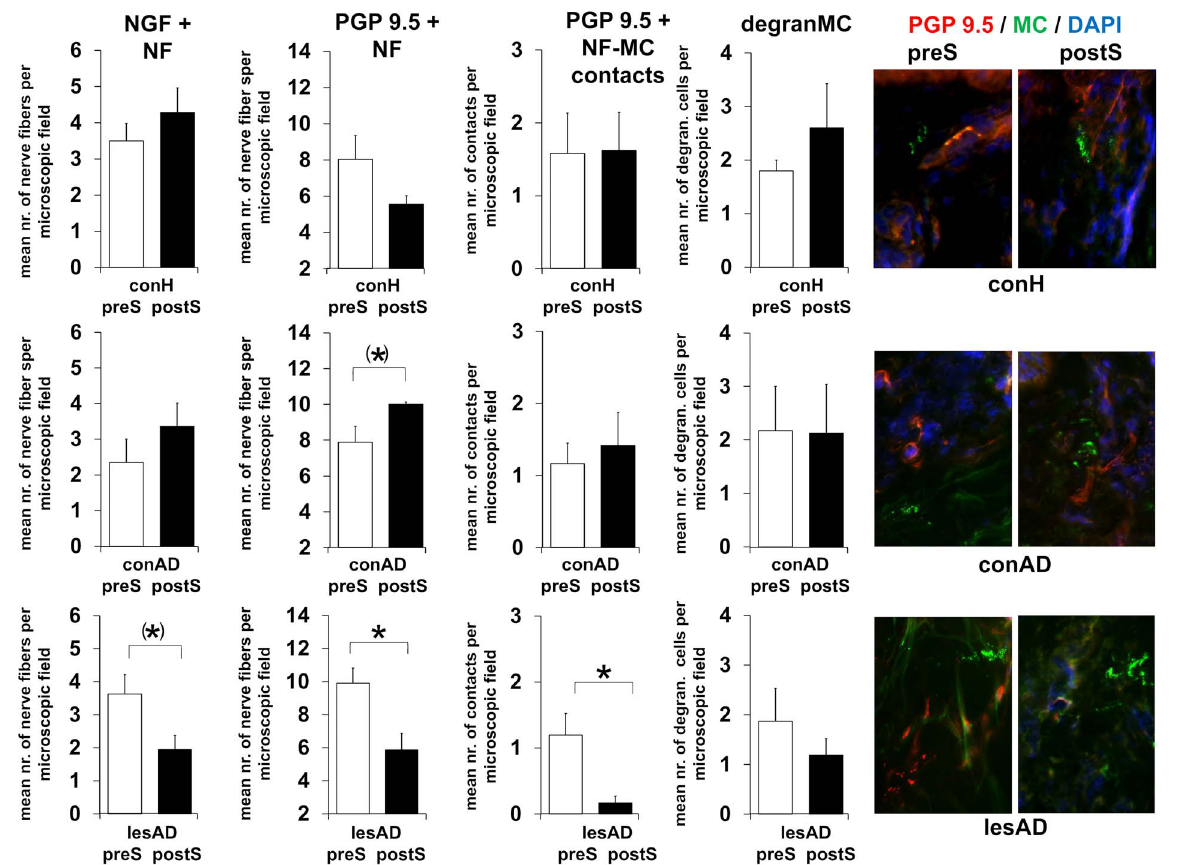
Figure 4. TSST induced neuro-immune changes in healthy control, non-lesional and lesional AD skin. Changes to baseline obtained as described in Figure 1 were determined 24 h after TSST. Number of participants per evaluation (NGF + NF, PGP 9.5 + NF, PGP 9.5 + NF-mast cell contacts, degranulated mast cells [MC]): control: N 5 11, 4, 4, 4; non-lesional AD: N 5 11, 4, 4, 4; lesional AD: N 5 11, 6, 6, 5. Corresponding raw data is provided as Data S1 . P- values: , 0.10 5 (*), , 0.05 5 *. Abbreviations: conH – healthy control skin, conAD – non-lesional AD skin, lesAD – lesional AD skin, preS – prior to TSST, postS – 24 h after